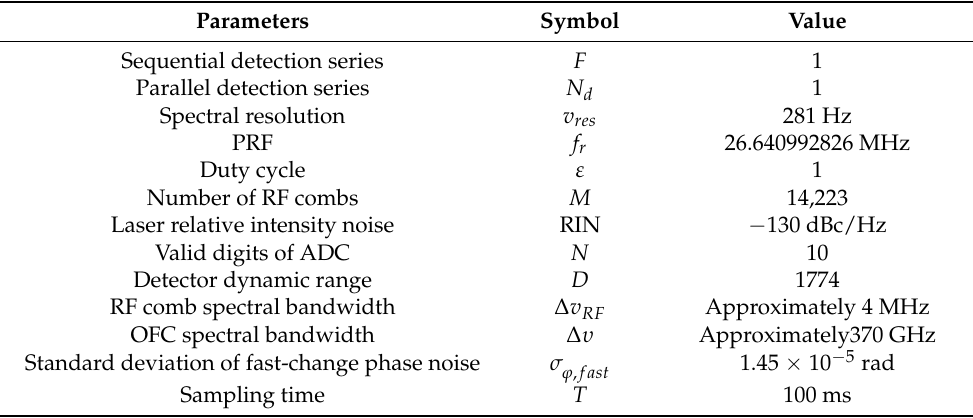
Table 2. Parameters used for the SNR